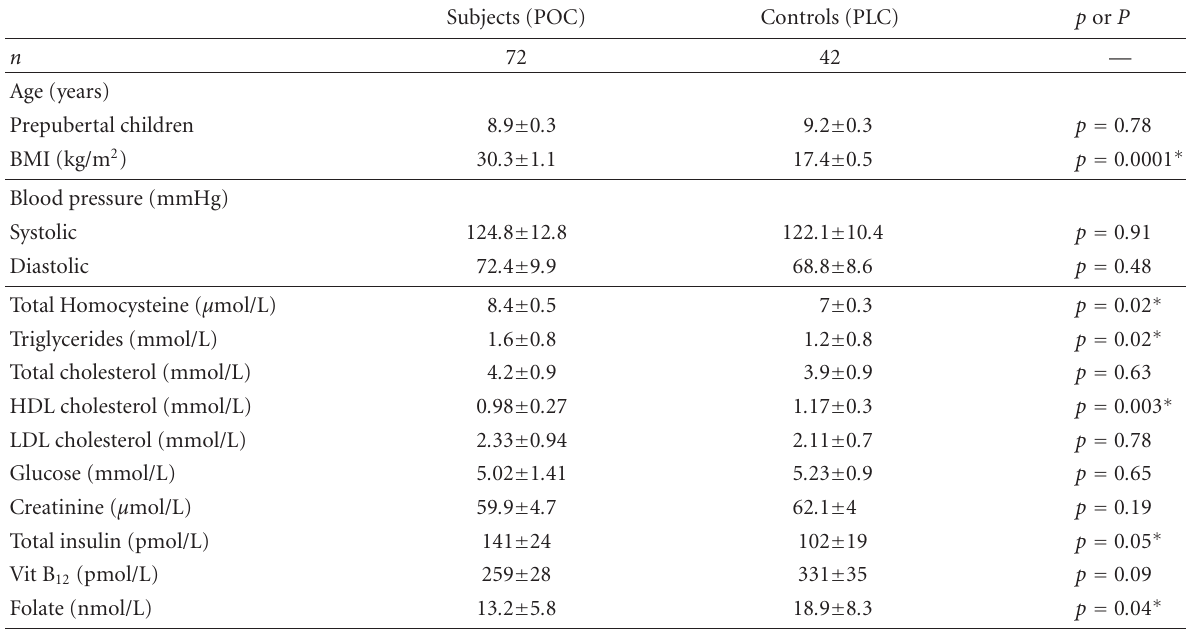
Table 1. Characteristics of the study participants. Data are n or means ± standard deviation.